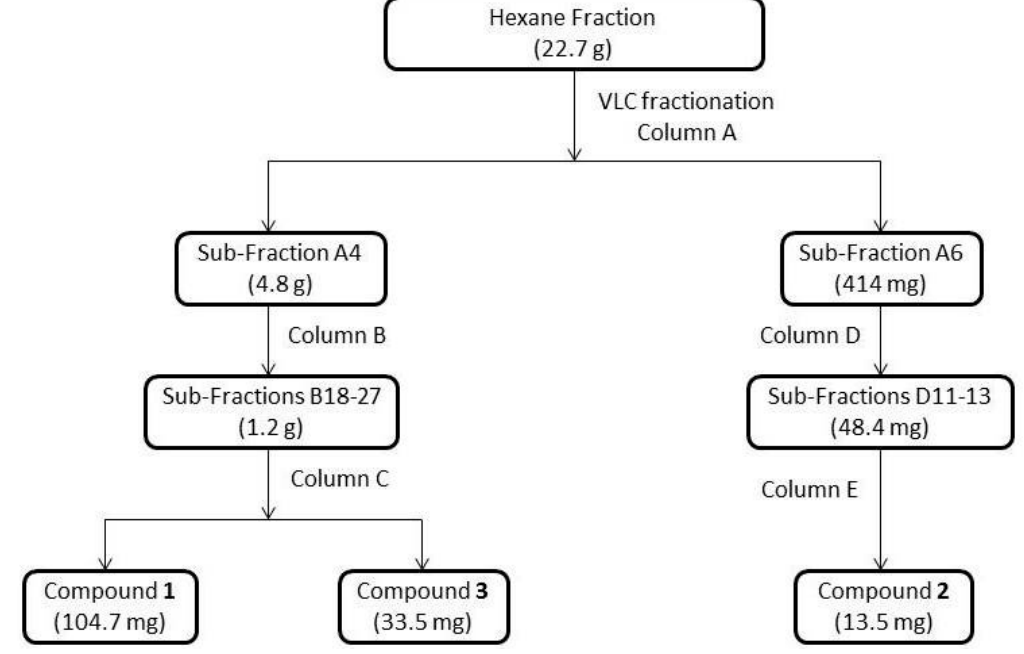
Figure 5. Flow chart for the isolation of the compounds 1 – 3 .